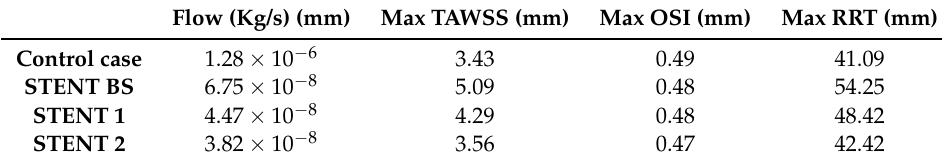
Table 2. Summary of the simulation results.